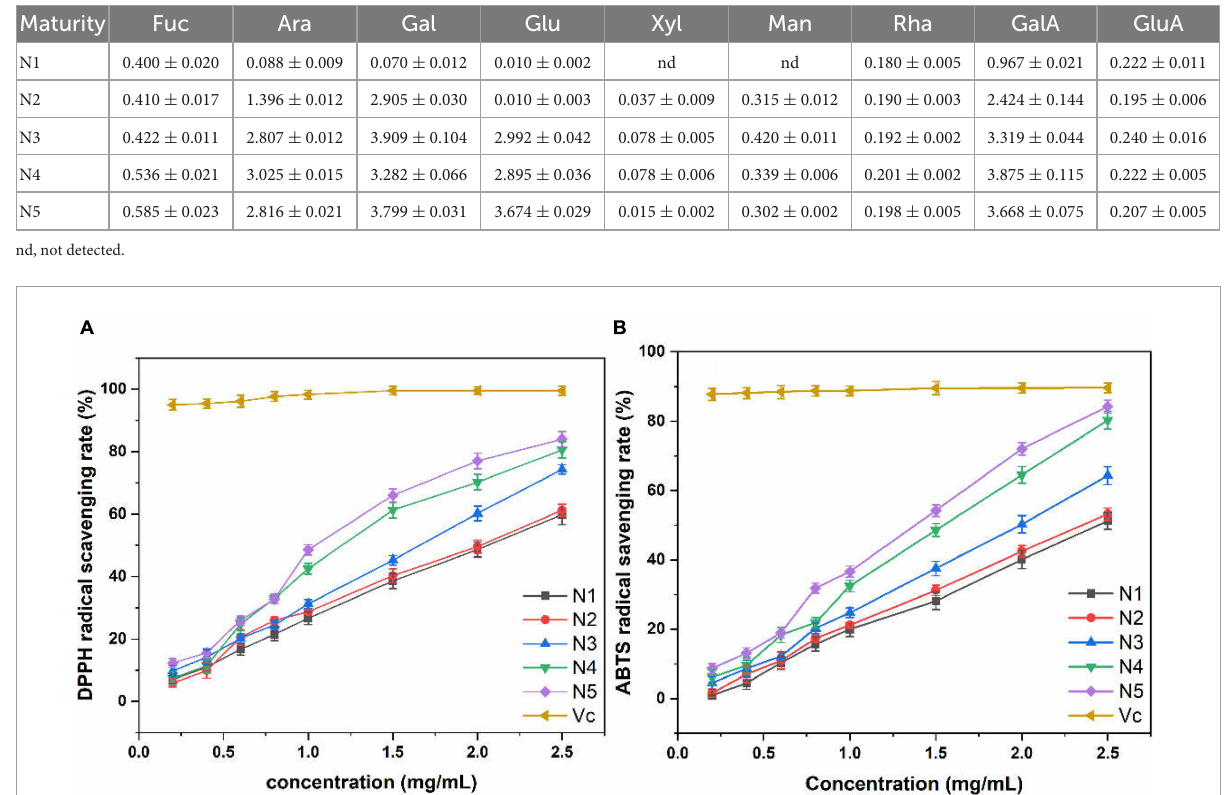
maximum concentrations of Gal (3.909 ± 0.104 mg/L) and Man (0.420 ± 0.011 mg/L) were found in N3, while the highest values of Ara (3.025 ± 0.015 mg/L) and GalA (3.875 ± 0.115 mg/L) were observed in N4. Moreover, the N5 sample had significantly higher levels of Fuc (0.585 ± 0.023 mg/L) and Glu (3.674 ± 0.029 mg/L)